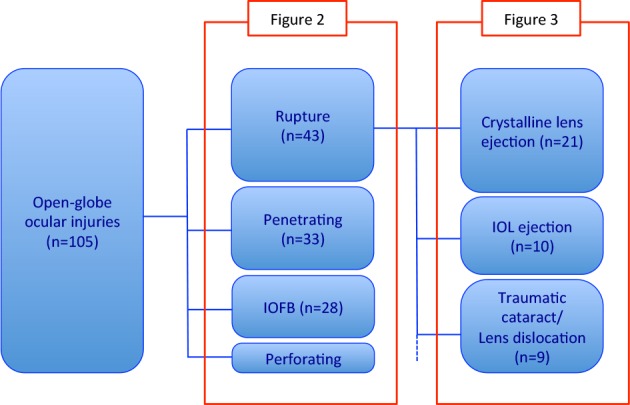
Schematic flow chart of this study.